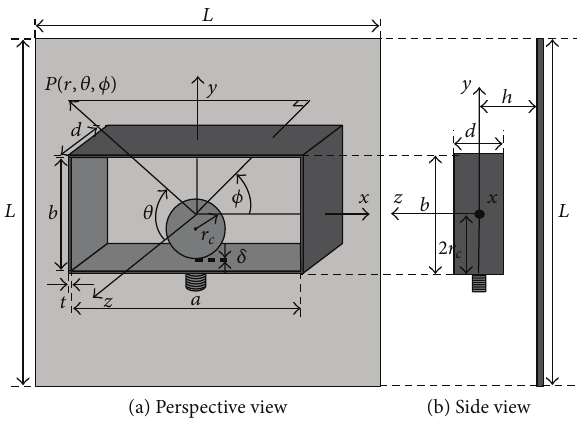
Figure 1: The structure of the proposed antenna with CDM.